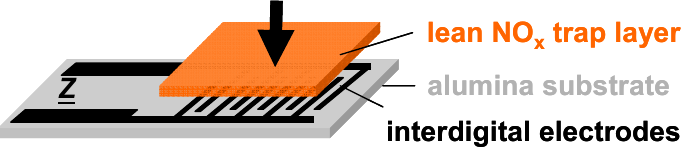
Figure 3. Setup of the accumulating-type NO